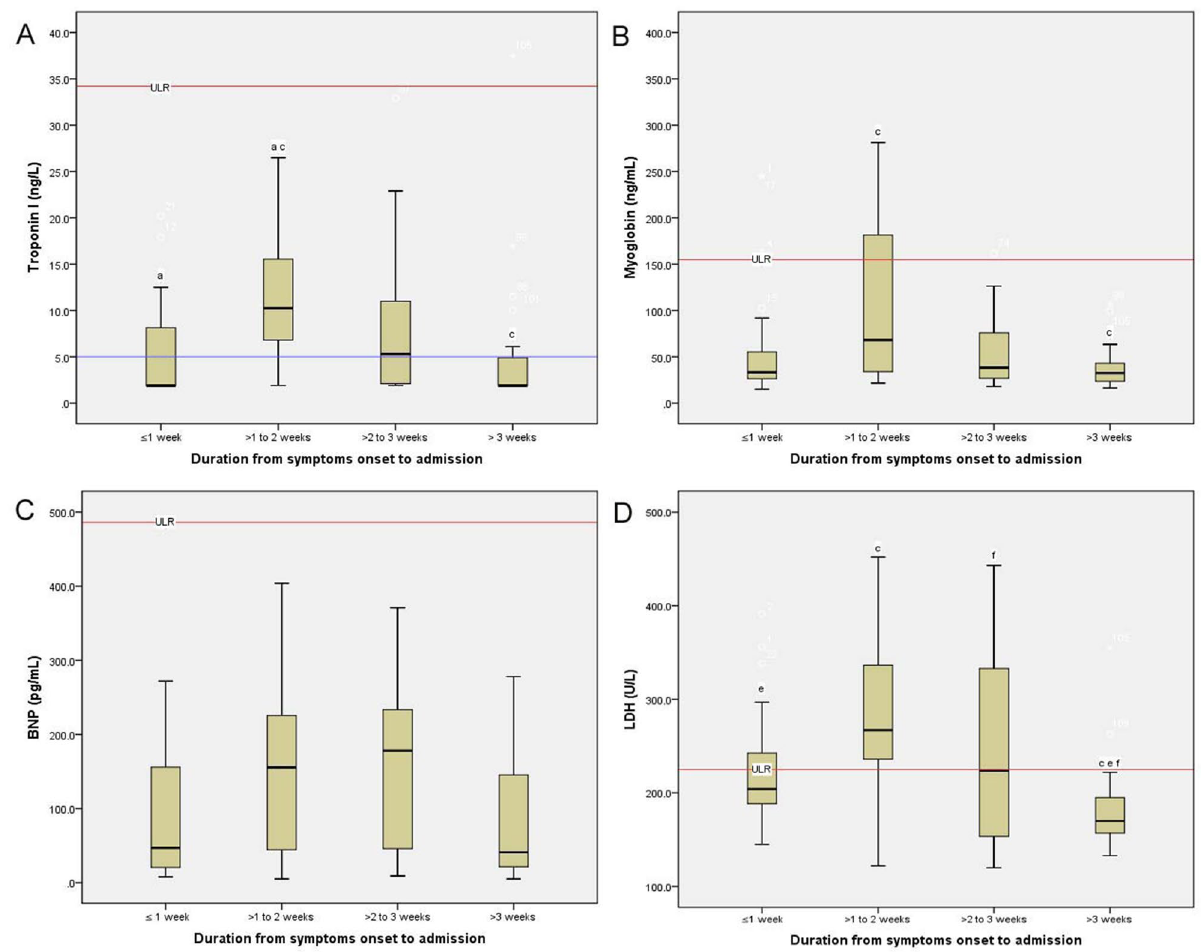
Figure 2. Simulative changes of cardiac biomarkers in non-severe patients with COVID-19 across the four groups. COVID-19 patients who were in the second week after symptoms onset presented the highest levels of hs-cTnI, myoglobin, BNP, and LDH. hs-cTnI, high sensitivity troponin I; BNP, B-type natriuretic peptide; LDH, lactic dehydrogenase; ULR, Upper limit of reference intervals; LLR, Lower limit of reference